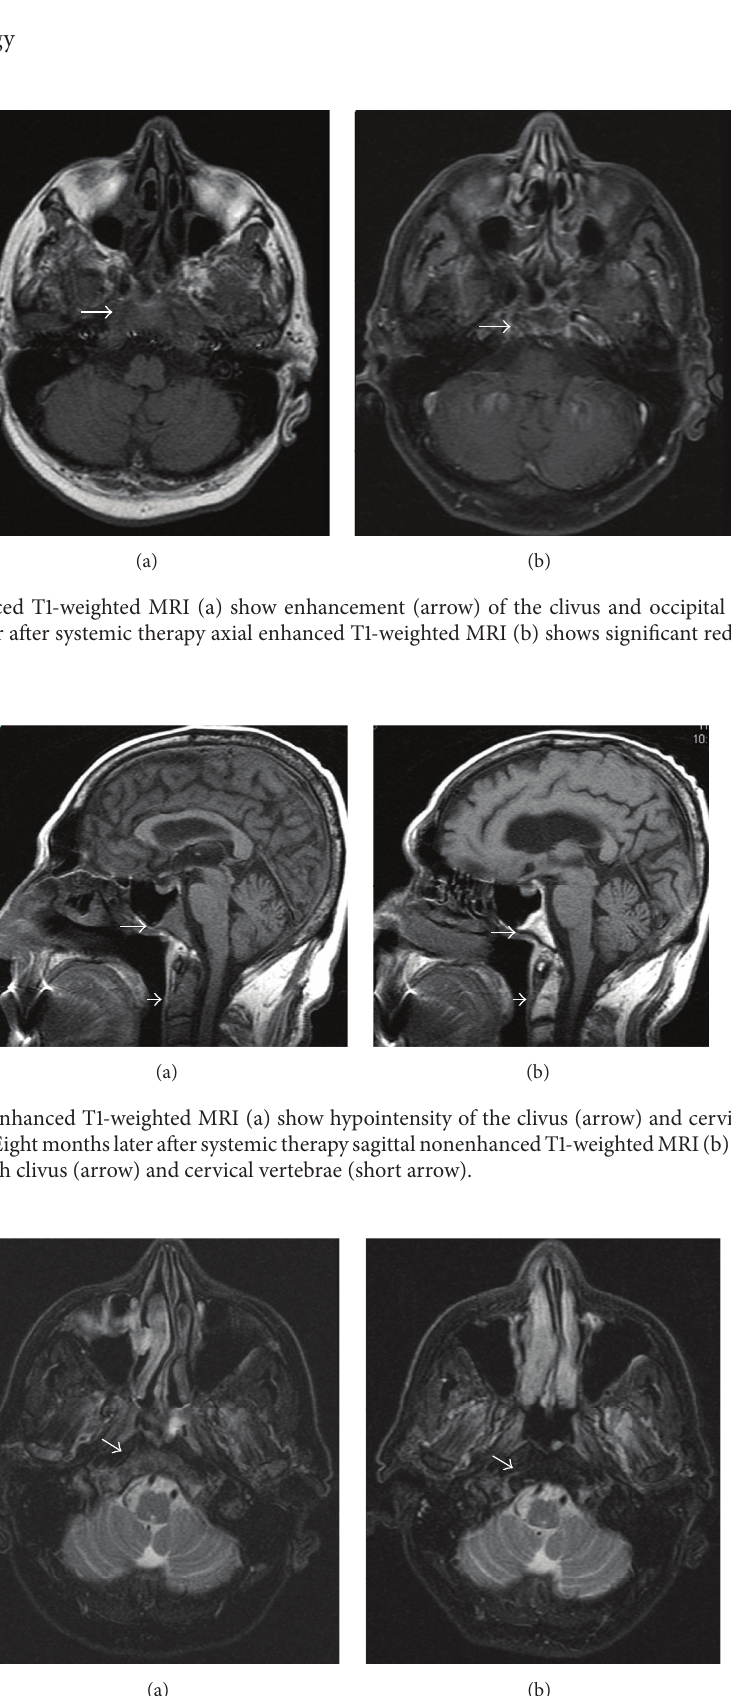
Figure 4: Axial T2 weighted fat-suppressed images before (a) and after therapy (b) clearly show reduction of the pathological hyperintensity of the clivus and occipital condyles corresponding to